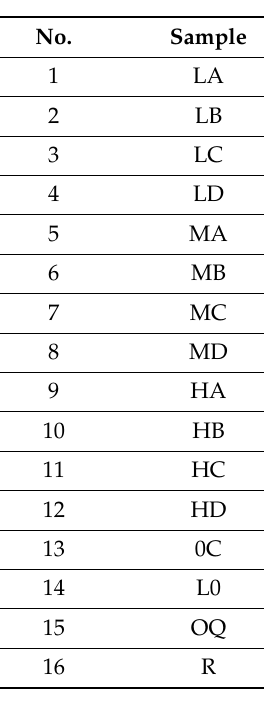
Table 3. Mixture proportions of binders /%.